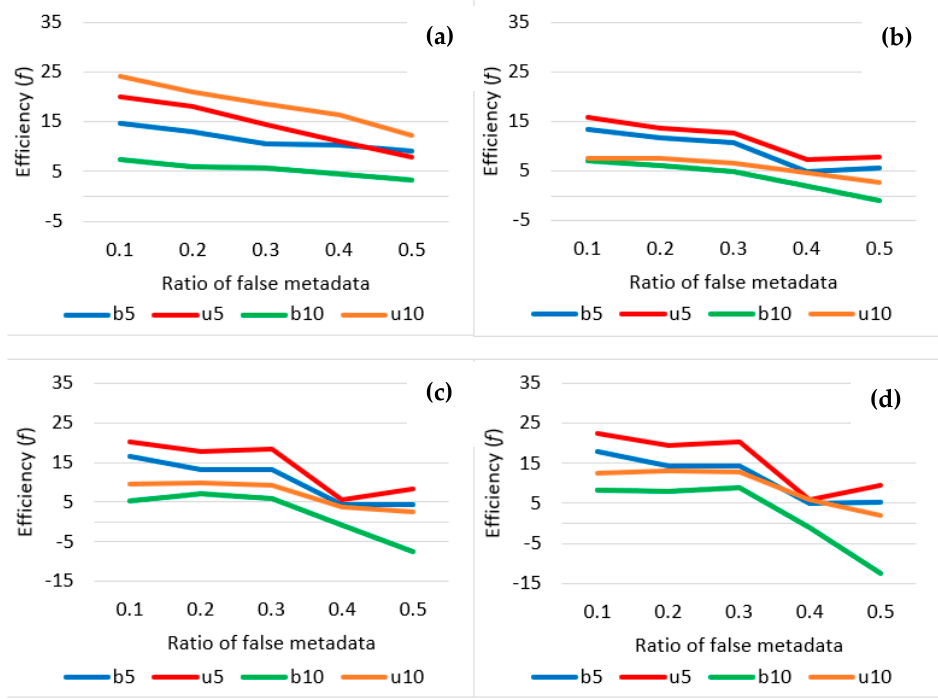
Figure 8. The same as Figure 4, but here the efficiencies are shown in the function of the ratio of false metadata. Upper left panel ( a ) CRMSEm, upper right panel ( b ) CRMSEy, bottom left panel ( c ) Trend bias for individual time series (Trbias), bottom right panel ( d ) Network mean trend bias (Trnetb).